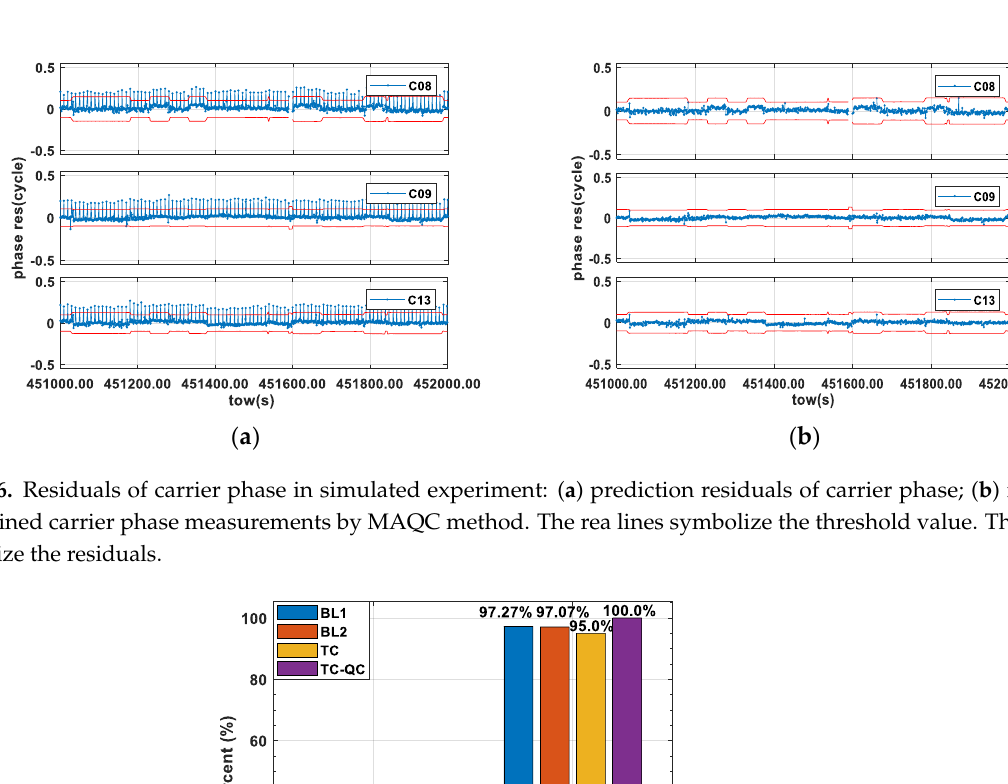
( b ) Figure 5. Residuals of carrier phase in real experiment: ( a ) prediction residuals of carrier phase; ( b ) residuals of the retained carrier phase measurements by MAQC method. The rea lines symbolize threshold value. The blue lines symbolize the residuals.